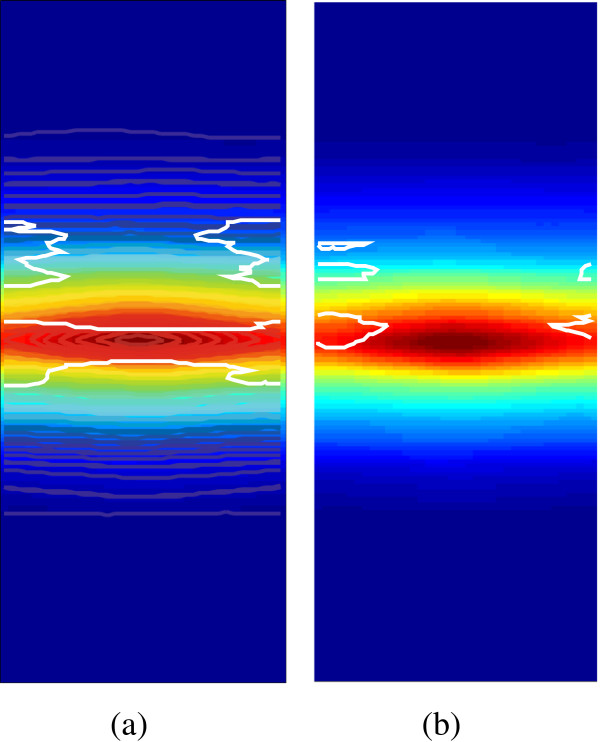
The region (in white contour) with significant dose difference (a) between AET Grade 0–1 and 2–3, and (b) between AET Grade 0–2 and 3, overlaid on the average dose map of the total 185 patients.